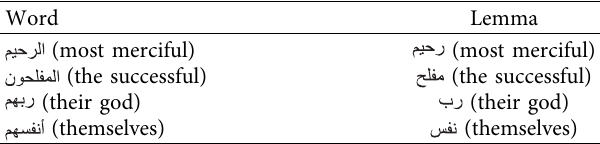
Table 2: Sample from the lemma